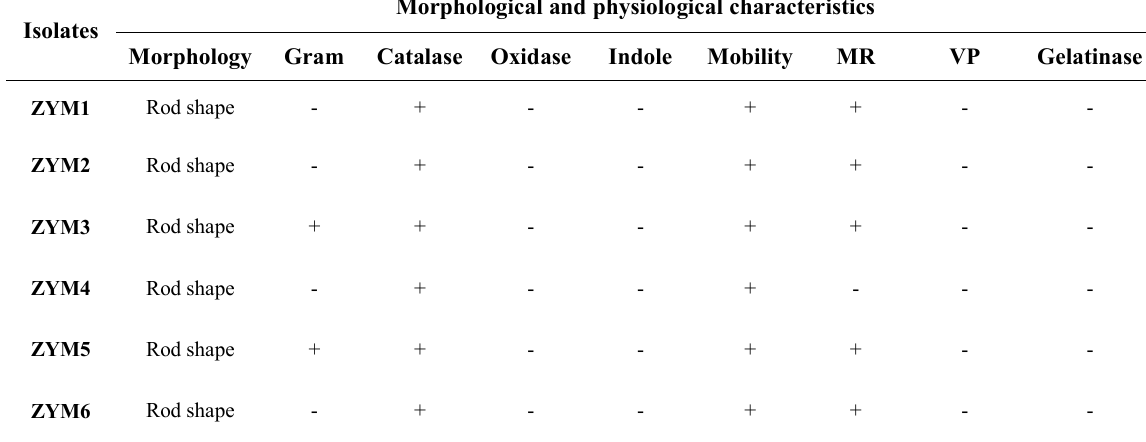
Table 1. Biochemical test of the isolated ethanol producing